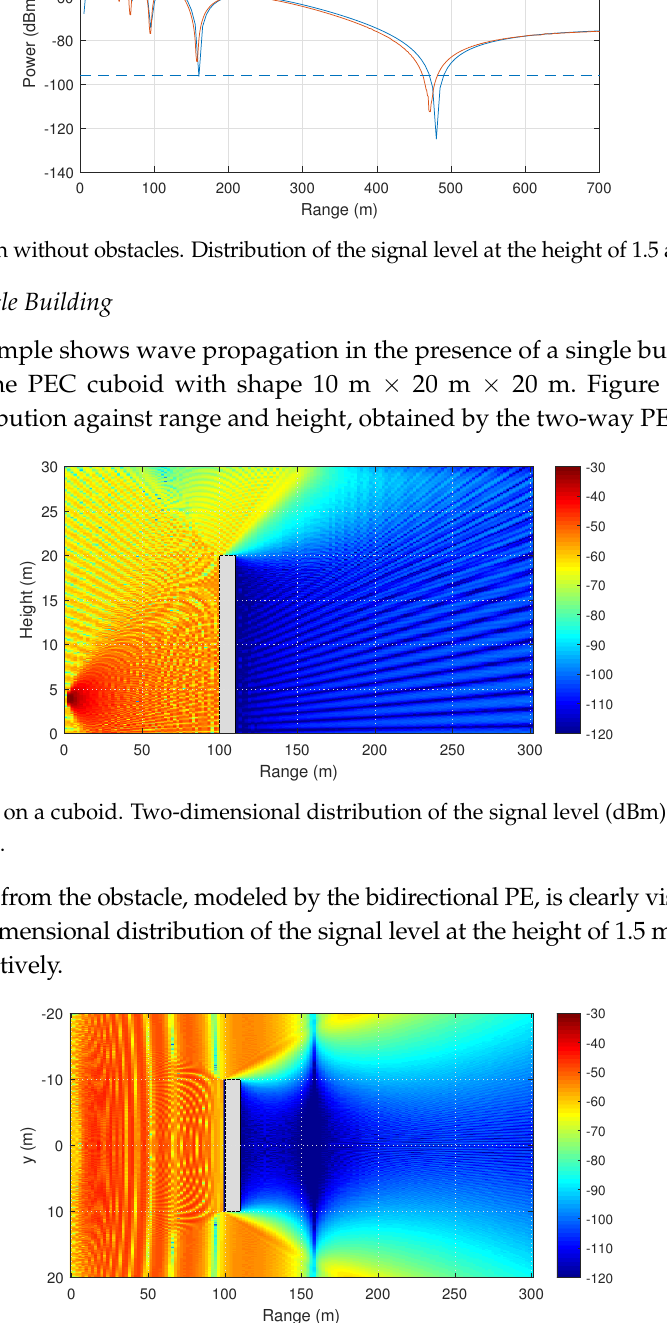
Figure 3. Diffraction on a cuboid. Two-dimensional distribution of the signal level (dBm) at the height of 1.5 m, calculated by the two-way PE